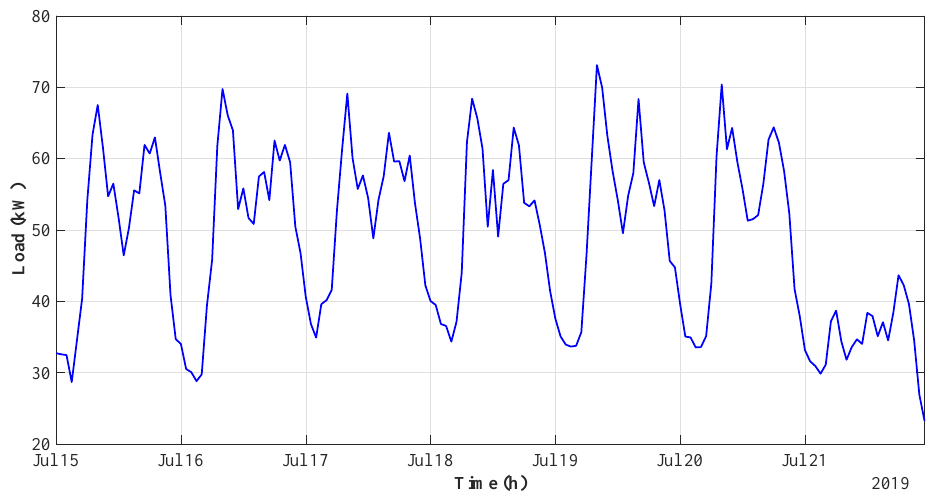
Figure 1. Weekly boat demand.